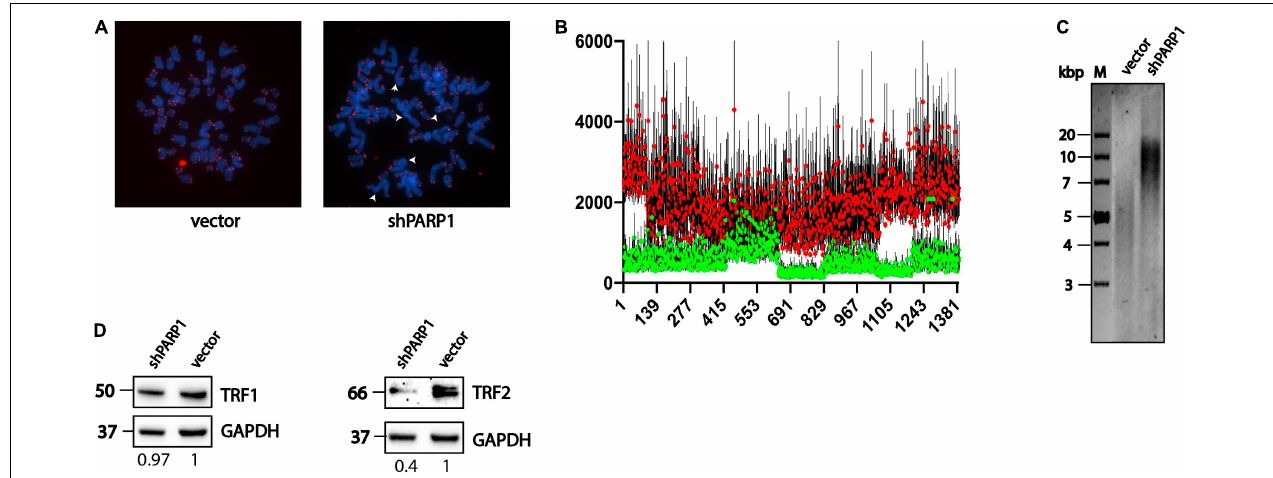
FIGURE 5 | PARP1 is involved in the regulation of telomere length and telomerase activity. (A) Immunofluorescence-FISH analysis of metaphase spreads from cells expressing the LeGo-Cer vector and a shRNA specific to PARP1 mRNA. White arrows point defects in telomeric structures. (B) Telomere length analysis performed by Telometer software by the Johns Hopkins University. Green dots correspond control cells (vector) and red dots correspond spreads from cells with decreased level of PARP1 (shPARP1). (C) Telomere restriction fragment length analysis of PARP1 knockdown cells. (D) Western blot analysis of TRF1 protein levels in the indicated cell lines. (E) Western blot analysis of TRF2 protein levels in the indicated cell